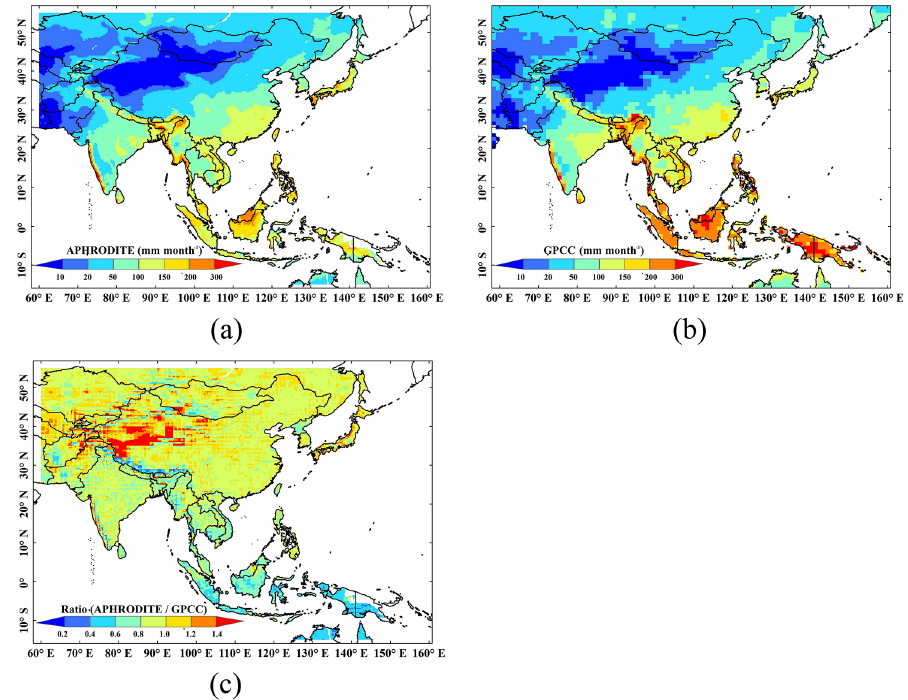
Figure 13. The spatial patterns of the monthly mean precipitation of (a) APHRODITE and (b) GPCC as well as (c) ratios between monthly mean values of APHRODITE and GPCC over Asia in the period from 1951 to 2015. For visualization, the spatial maps were generated using ArcGIS 10.3